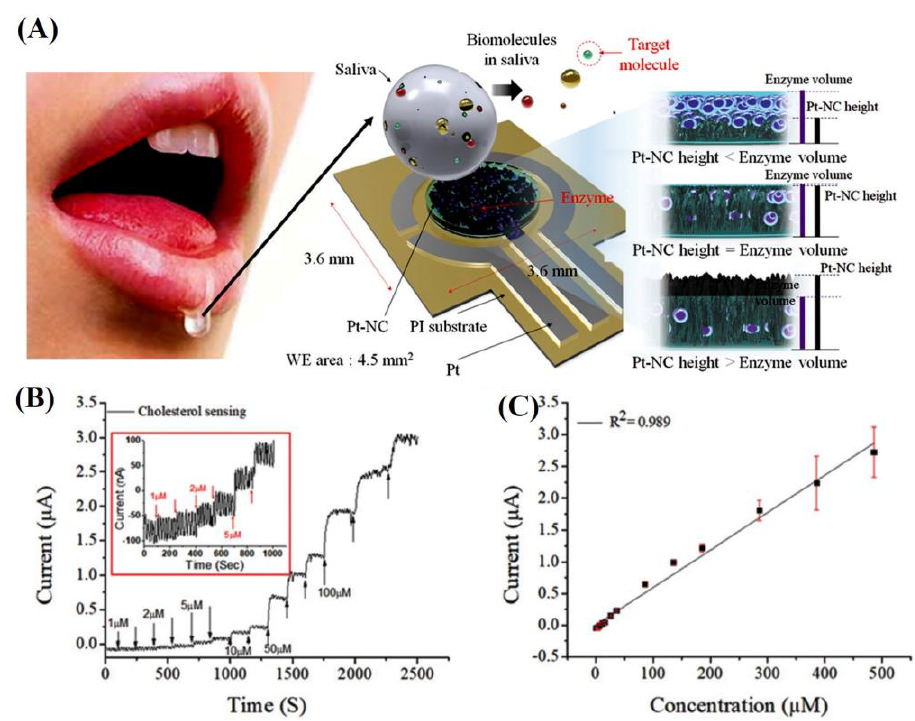
Figure 4. ( A ) A schematic for an electrochemical biosensor with a Pt nanocluster and the strategic approach for improving sensor’s performance by optimizing between the effective surface area and enzyme volume, ( B ) amperometric response for sensors with Pt nanocluster/enzyme/Nafion to the consecutive addition of total cholesterol under the conditions of continuous stirring in 0.1 M PBS buffer. ( C ) Calibration curve fitting [34]. Reprinted with permission from ref. [34]. Copy- right 2020 Royal Society of